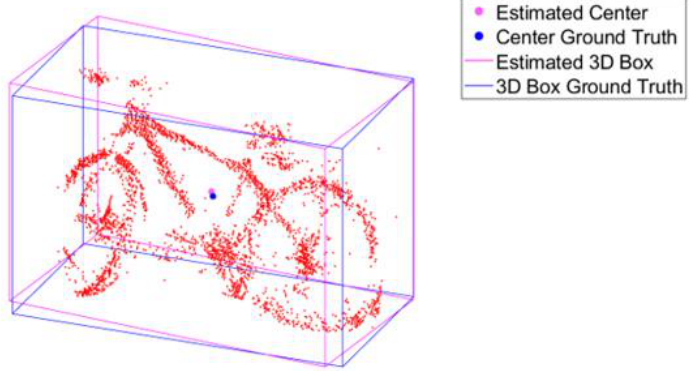
Figure 19. Refinement and Location Results for the bike object in Figure 16.